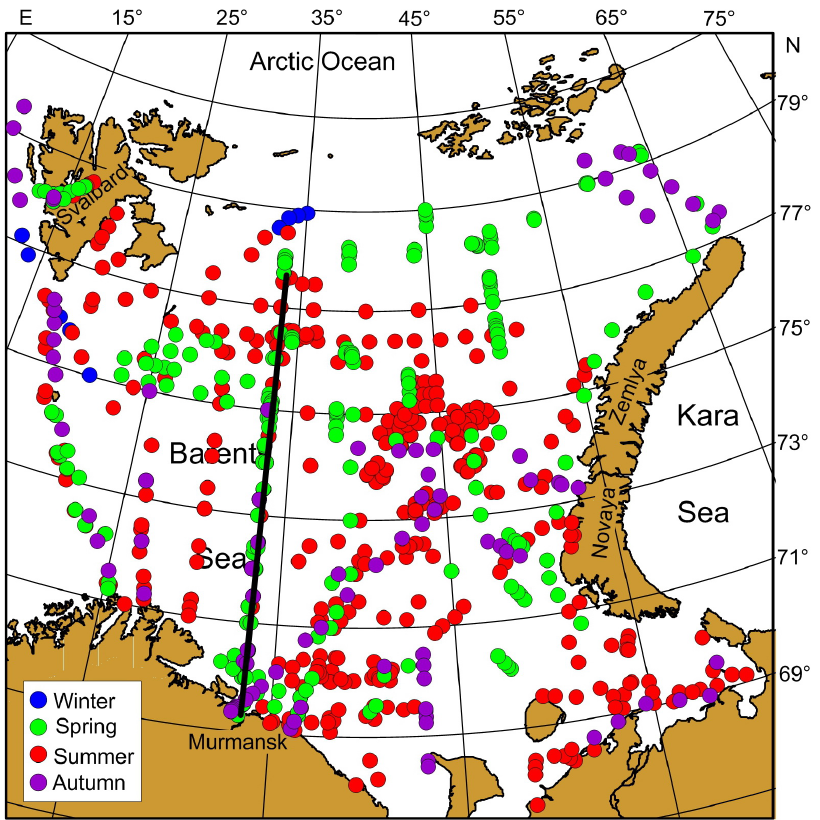
Figure 2. Sampling locations in the Barents Sea during 1984–2021. Solid black line indicates the Kola Section (69°30 ′ –77°30 ′ N, 33°30 ′